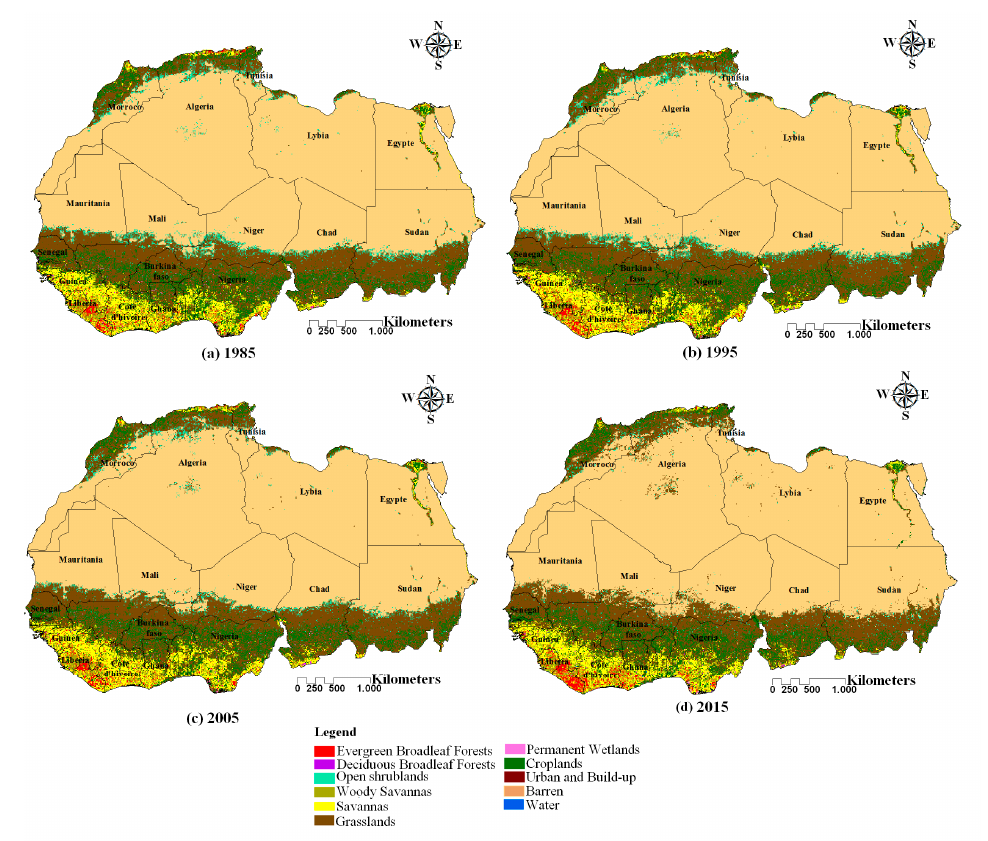
Figure 1. Annual LULC maps of the study area, produced by random forest classification. ( a ) 1985, ( b ) 1995, ( c ) 2005, and ( d )